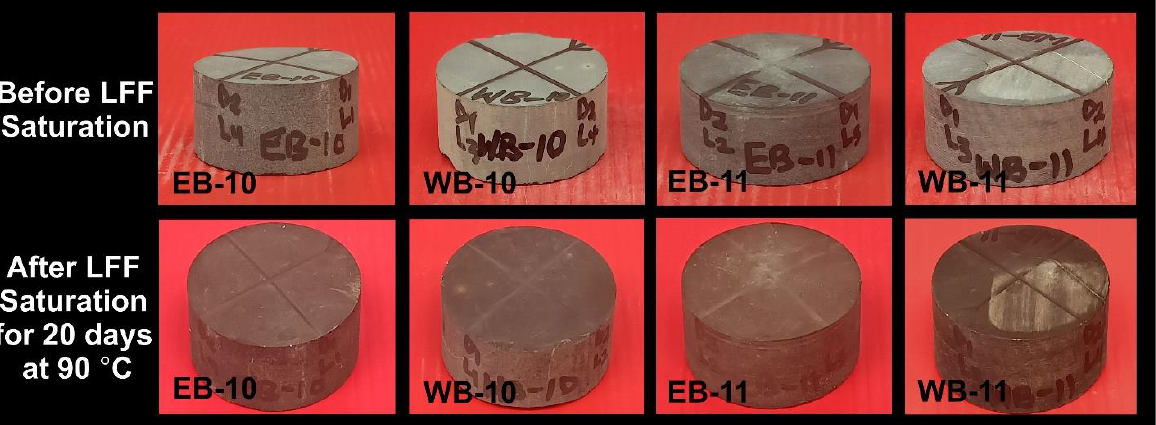
Figure 11. Pre- and Post-LFF saturations of Eagle Ford and Wolfcamp shales at 90 °C for a period of 20 days. EB-10 and WB-10 were LFF 1 saturated, while EB-11 and WB-11 were LFF 2 saturated.